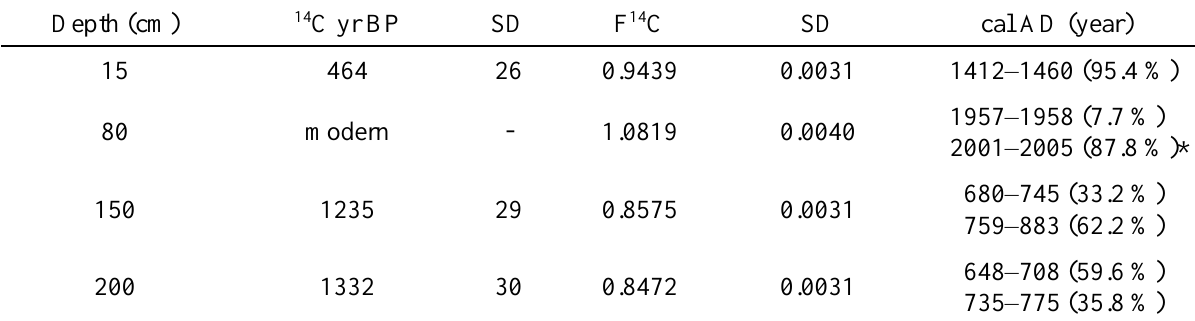
Table 2. Radiocarbon results (errors are 1σ) for Lushala peat. Calibration was performed using the IntCal20 (Reimer et al . 2020) and Bomb13 SH3 (Hua et al. 2013) calibration curves. Material codes are described in Crann et al . (2017). Note that the (% values) are probability densities. SD = standard deviation. Depth